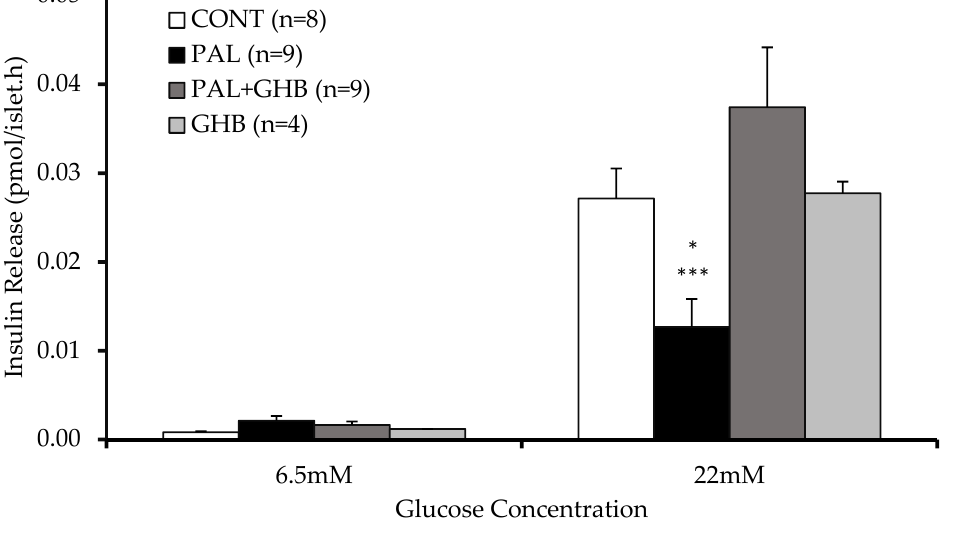
Figure 1. Effects of palmitate and gamma-hydroxybutyric acid (GHB) on glucose-stimulated insulin secretion in mouse islets. Islets were treated for 48 hrs with (1) control media, (2) palmitate (0.4 mM), (3) palmitate (0.4 mM) and GHB (5 mM), and (4) GHB (5 mM) alone. GSIS was performed after 1 h recovery. Palmitate treatment impaired GSIS while GHB restored GSIS in palmitate treatment. GHB by itself did not affect GSIS. Data are means ± SE. One-way nonparametric ANOVA on ranks for repeated measurements followed by Tukey’s test was performed to compare differences between treatments. * p < 0.05 vs. all, *** p < 0.001 vs. PAL + GHB.